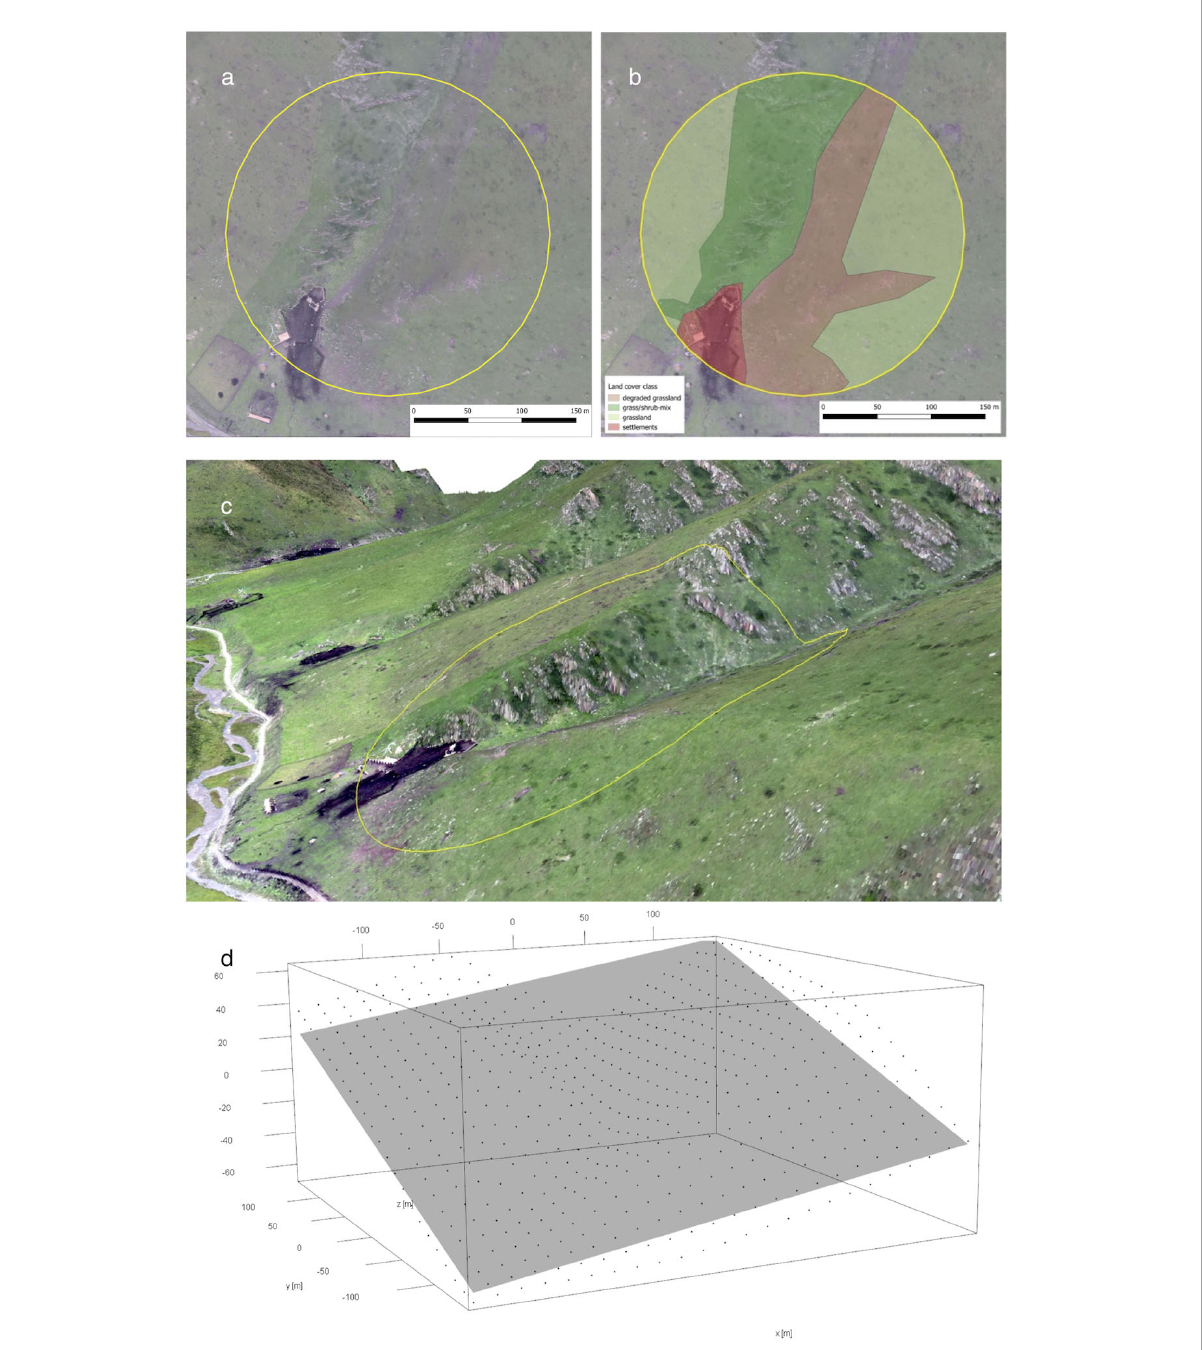
FIGURE 1 Ortho image (A) of sample plot 510 and the manually classi fi ed land cover classes (B) . (C) A 3D visualization of the plot facing northeast. This plot has been compared to plots with simpler topography and a high 3D complexity value. The deviation from a best- fi t plane is high (D)